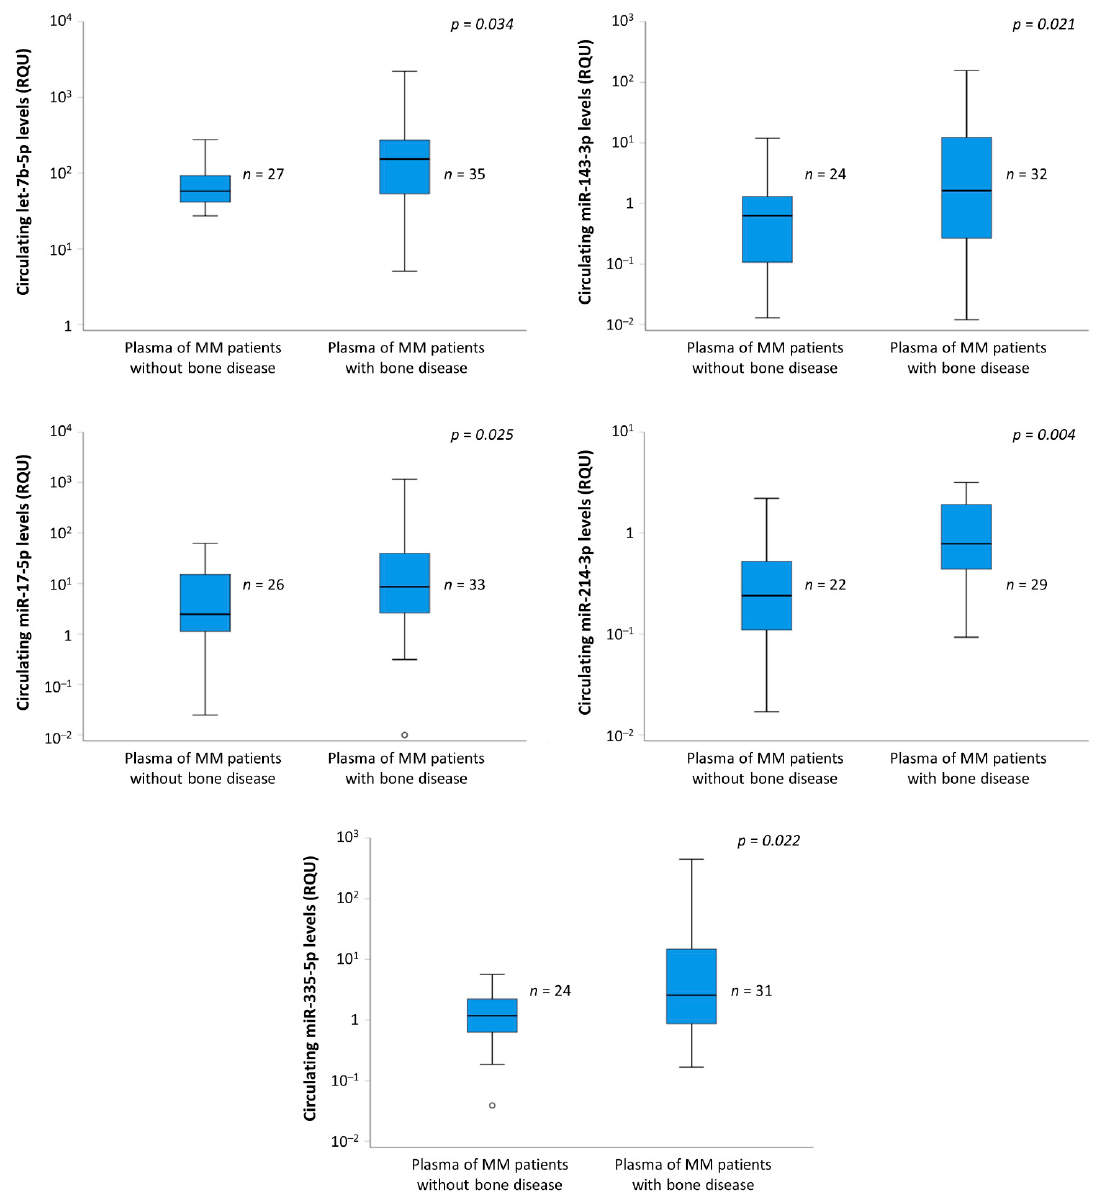
Figure 1. Comparison of let-7b-5p, miR-143-3p, miR-17-5p, miR-214-3p, and miR-335-5p levels in plasma of MM patients with and without MMBD. The expression of all miRNAs was higher in MM patients with MMBD compared to those without MMBD. Table 2. Univariate logistic regression for predicting the presence of MMBD, based on the levels of let-7b-5p,